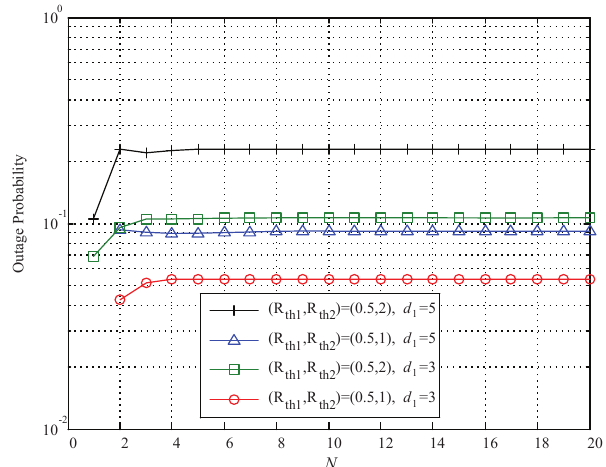
Figure 2. Effects of N on the outage probability for static JRA scheme.